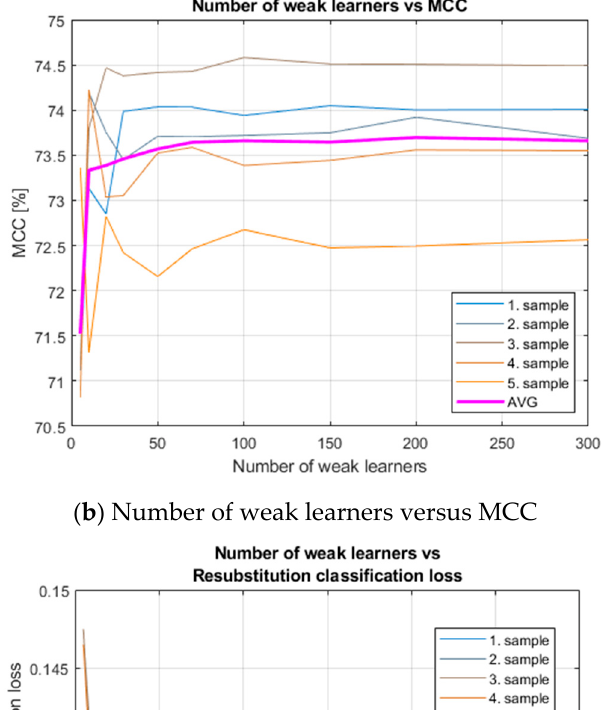
14 of 26 ( c ) REG versus Validation classification loss ( d ) REG versus Resubstitution classification loss Figure 1. Summary of iteration of the Robust Error Goal parameter versus the performance metrics and classification loss in the RobustBoost element.